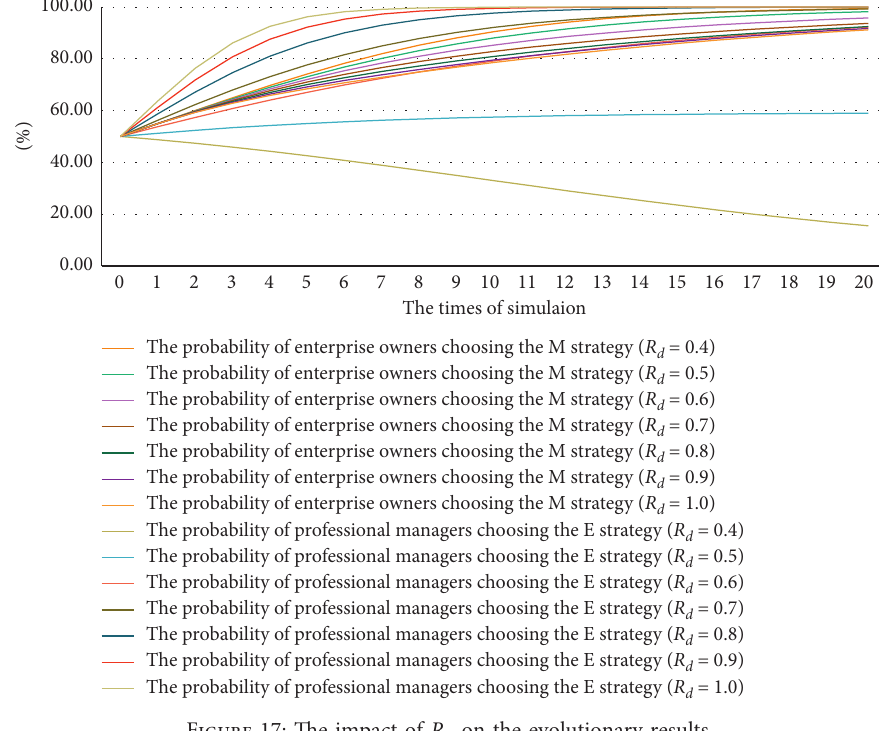
Figure 17: The impact of R d on the evolutionary results.